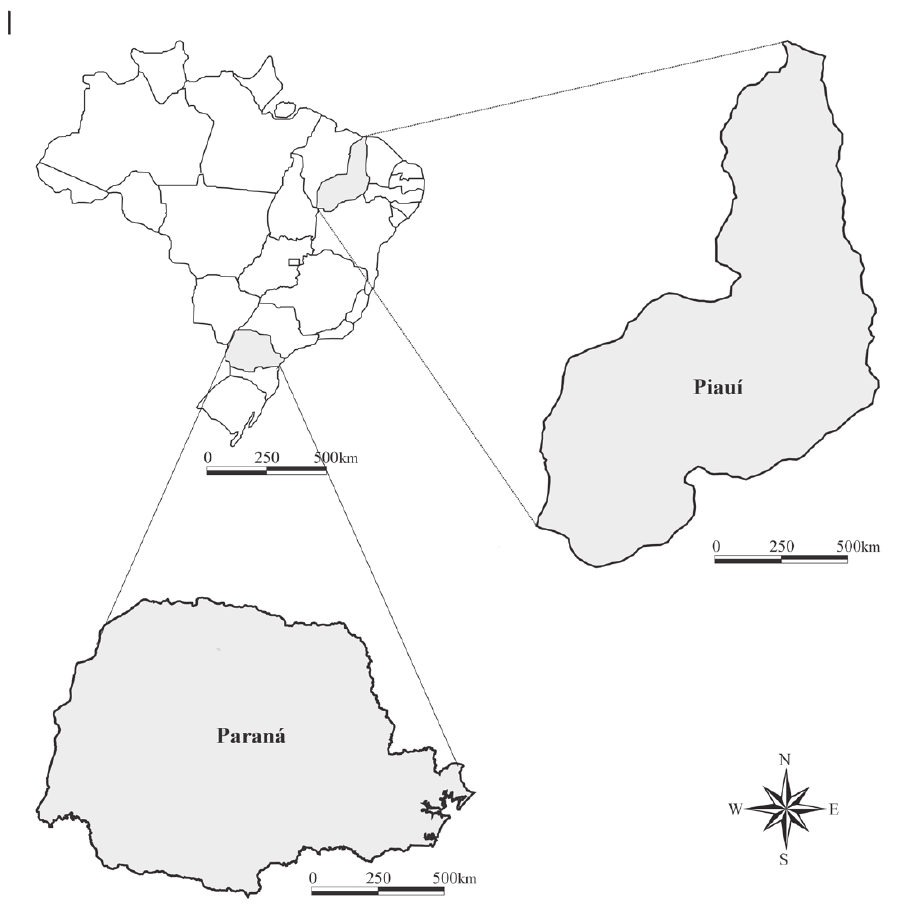
Figure 1 - Map of Brazil highlighting the states of Paraná and Piauí in the South and Northeast,